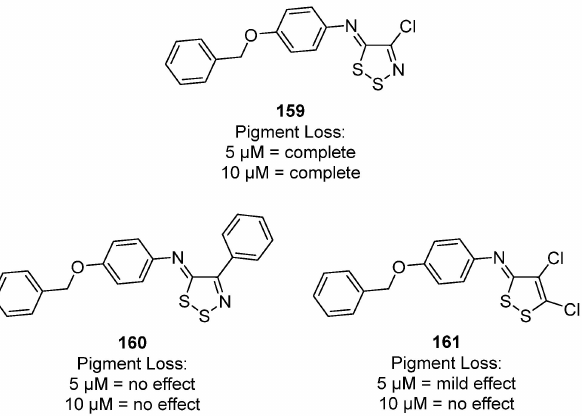
Figure 38. Direct comparison of 1,2,3-dithiazole 159 with disrupted analogues 160 and 161 in In vivo pigment loss in Xenopus laevis